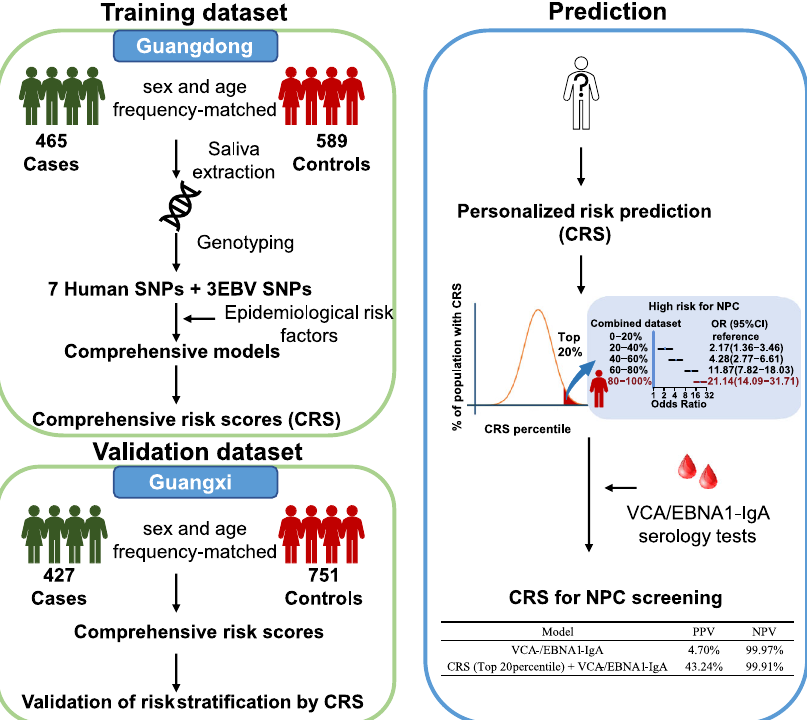
Fig. 1 Work fl ow of comprehensive risk score (CRS) construction and its application in NPC screening. The CRS was developed using EBV, host genetic and epidemiological risk factors for NPC risk prediction with a discovery dataset from Guangdong province, and validated in an independent dataset from Guangxi province. The CRS was combined with EBV serology tests for NPC screening. Table 1 Demographic characteristics of the study participants in the training and validation